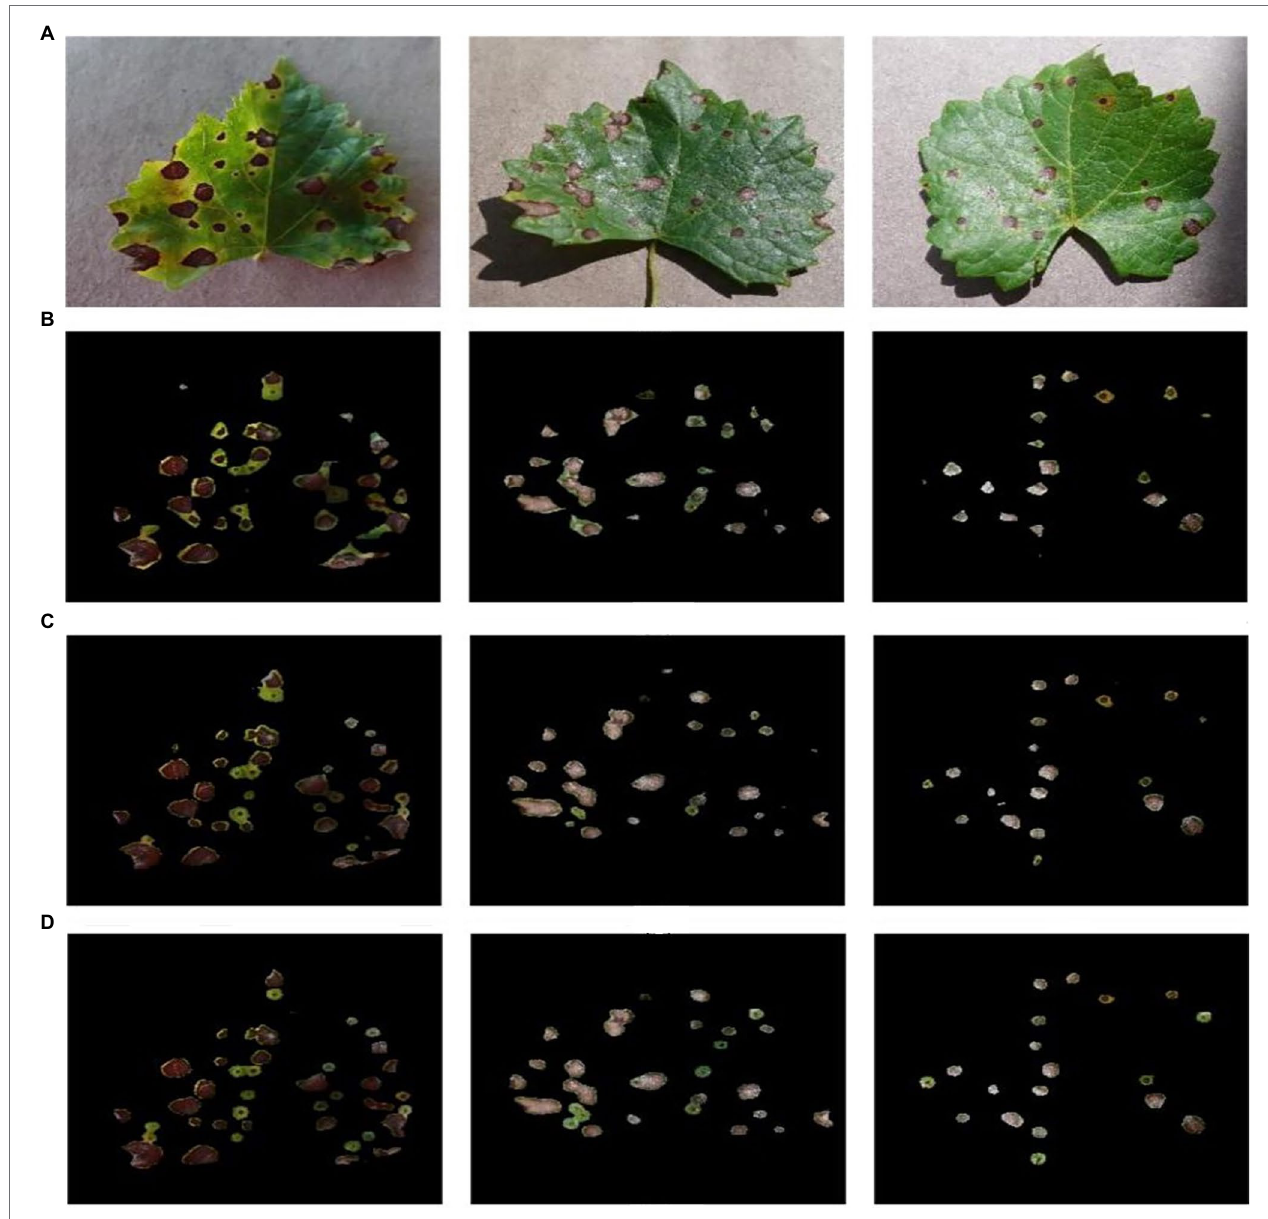
FIGURE 12 | Comparison of the segmentation results of different segmentation algorithms on the test set TS1 images. (A) The original image, (B) the PSP Net segmentation and extraction results, (C) the U-Net segmentation and extraction results, (D) improved DeepLab v3+ segmentation and extraction results.